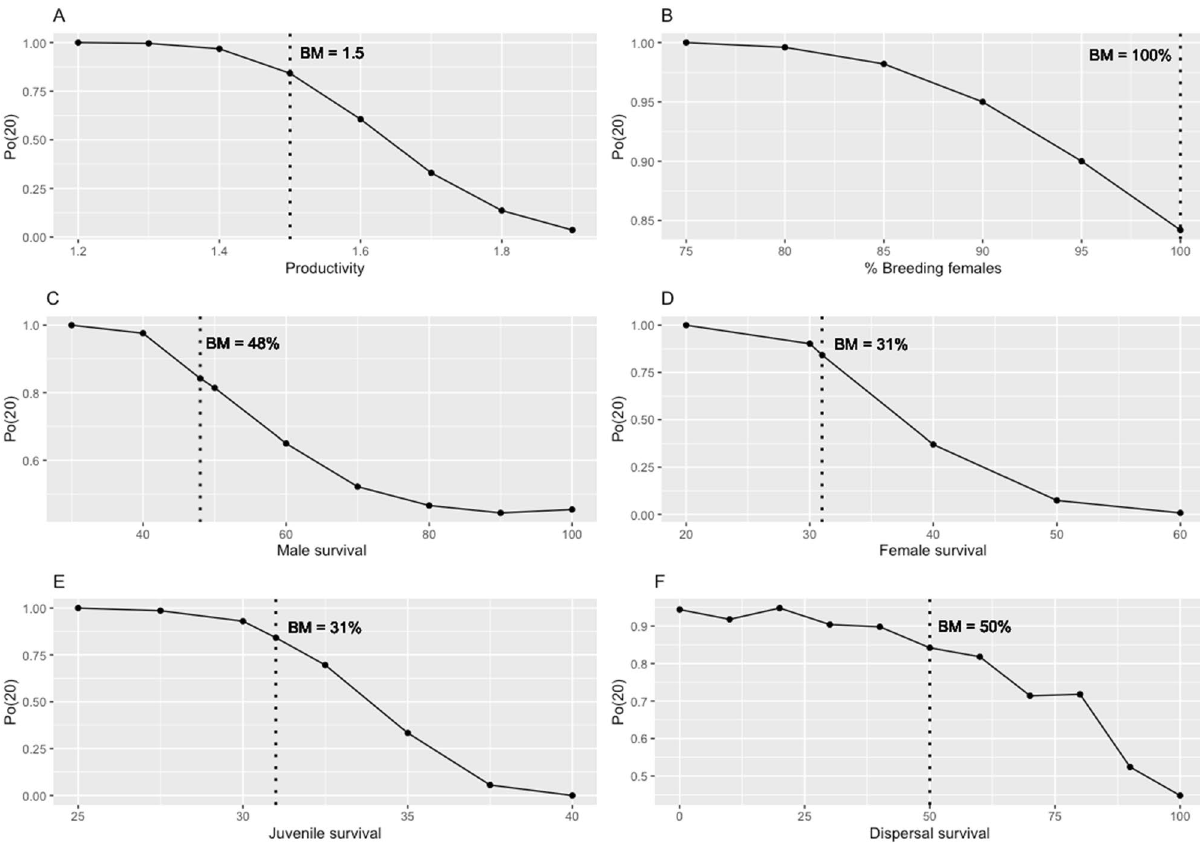
Figure 1. Sensitivity of the probability of metapopulation extinction in 20 years, P 0 (20) , to the different parameters evaluated. Dotted lines represent the value used in the base model (BM). ( A ) Productivity (offspring/brood); ( B ) % of breeding females; ( C ) Adult male survival; ( D ) Adult female survival; ( E ) Juvenile survival (both sexes); ( F ) Survival of dispersers. See effects on r , T mean and T max in Supplementary Table S3 and Supplementary Figs.